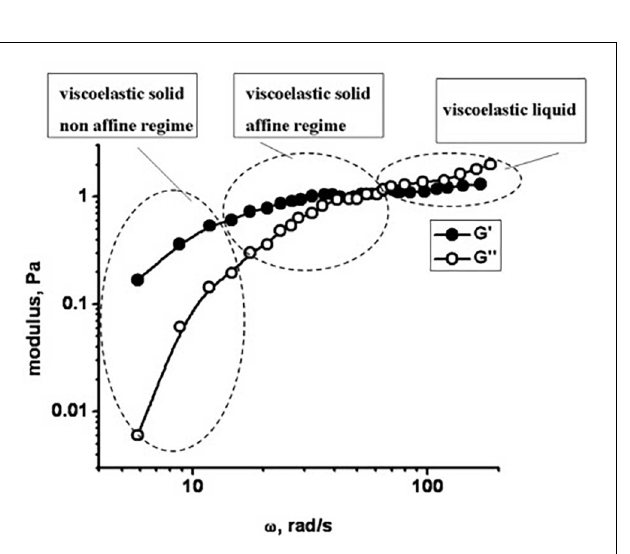
(Chen et al., 2007), with a feedback impact on the distribution of band-3 and Hb